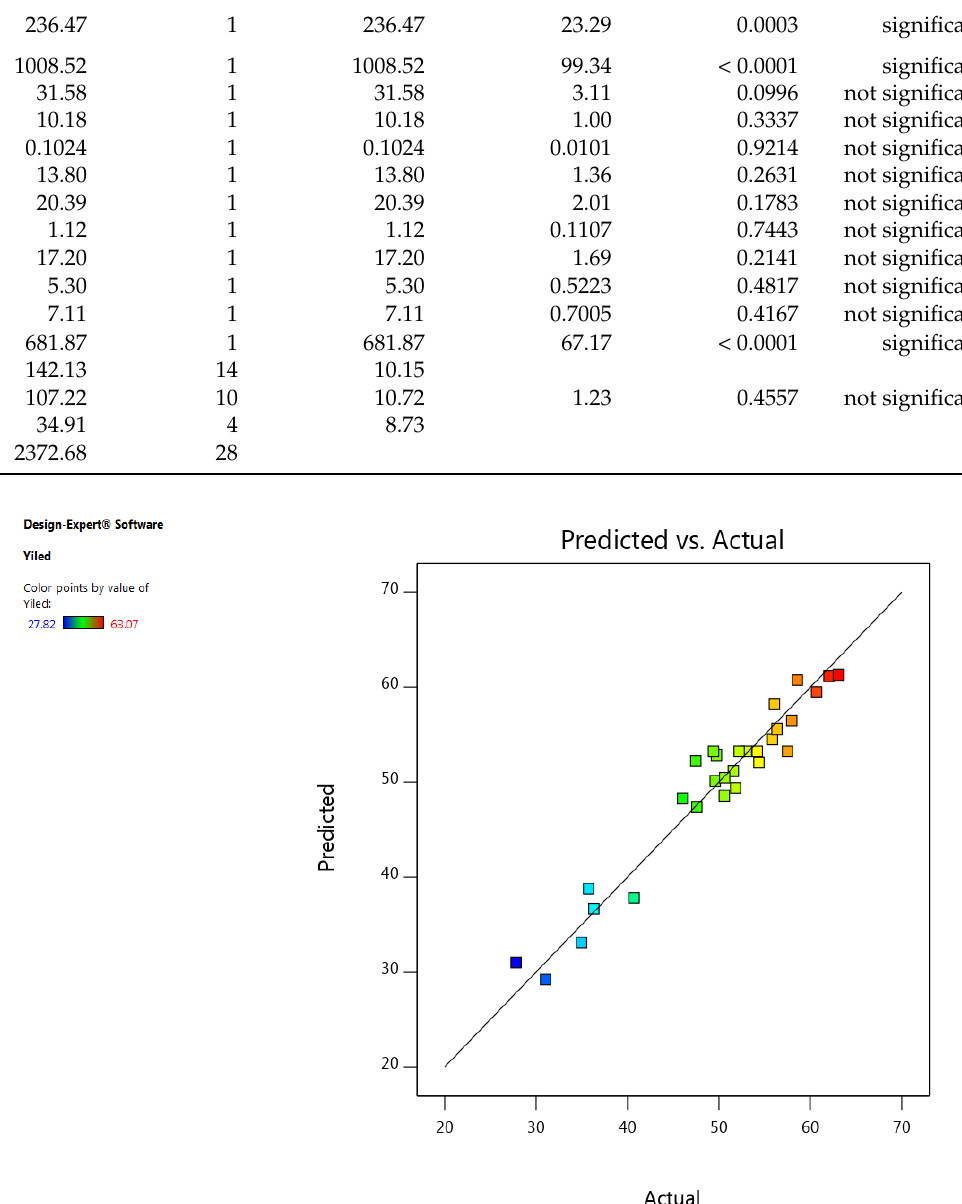
Figure 2. Actual experimental data versus predicted model.